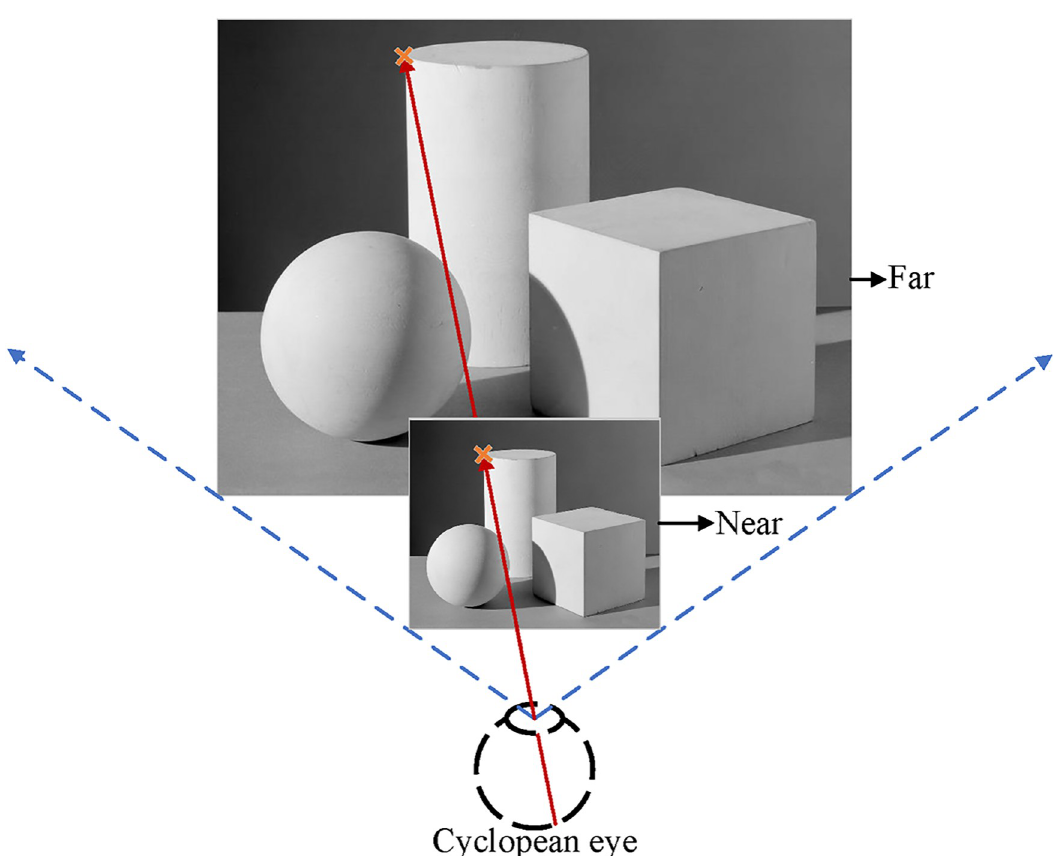
Fig 2. Visual eccentricity from the cyclopean eye represents monocular depth cues, including perspective, occlusion, shade and shadow, and texture gradient. The far and the near objects project to the same retina locations of the cyclopean eye and are indistinguishable based on the monocular depth